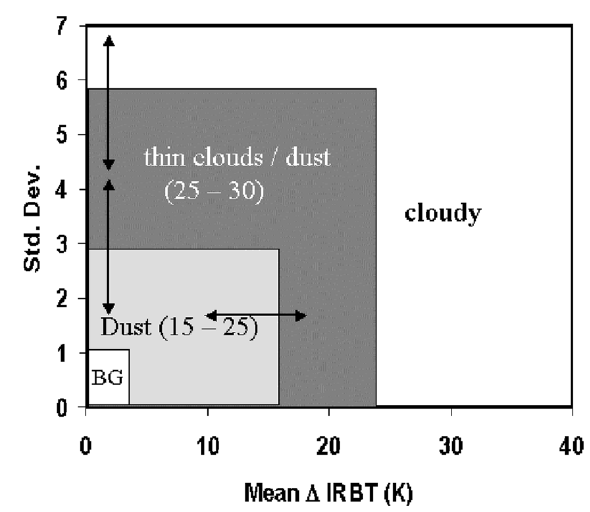
Fig. 6. A typical representation of the thresholds representing the background dust condition, normal dust conditions and cloudy con- ditions. The boundary between the clear and cloudy conditions is also shown. In this situation cloud screening is